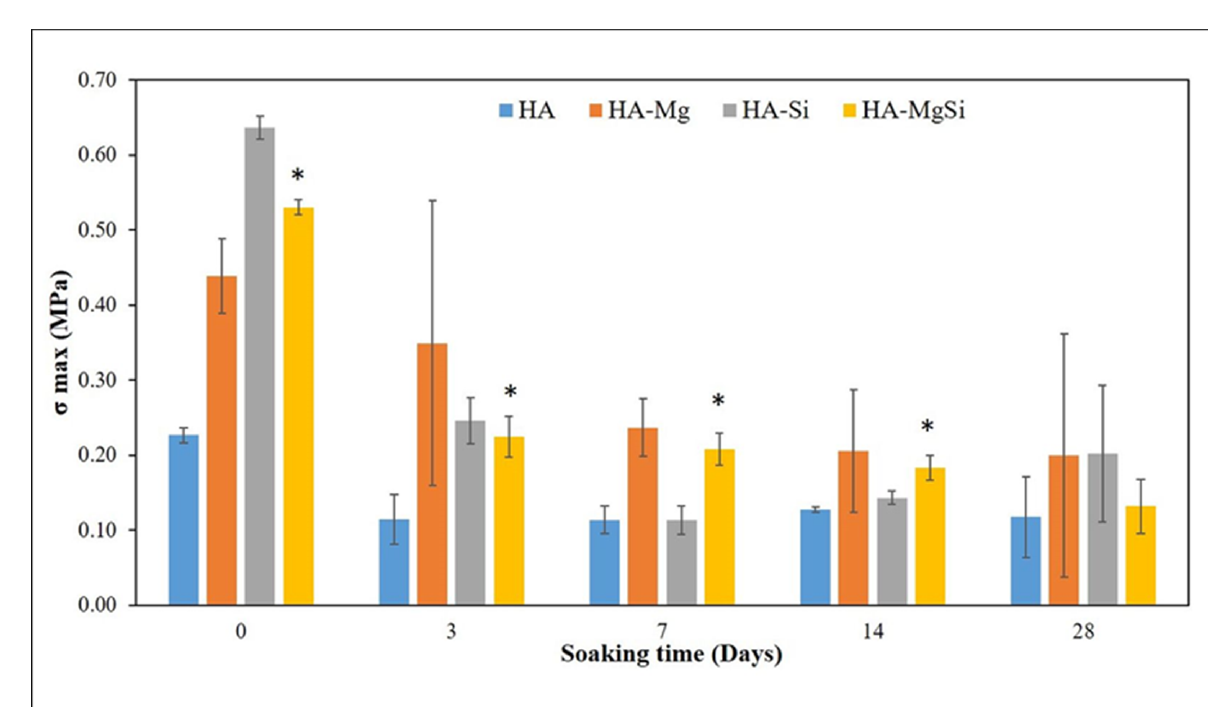
Figure 7. Plot of mechanical strength during soaking in Tris-HCl. Average values with standard deviations are reported (n = 6). * p < 0.05 (HA-MgSi versus HA).